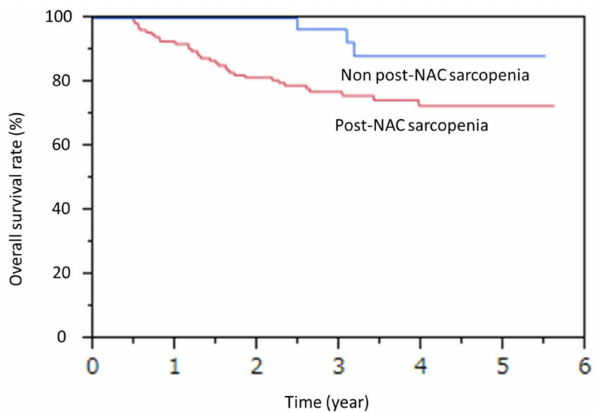
Figure 1. Overall survival by cStage.